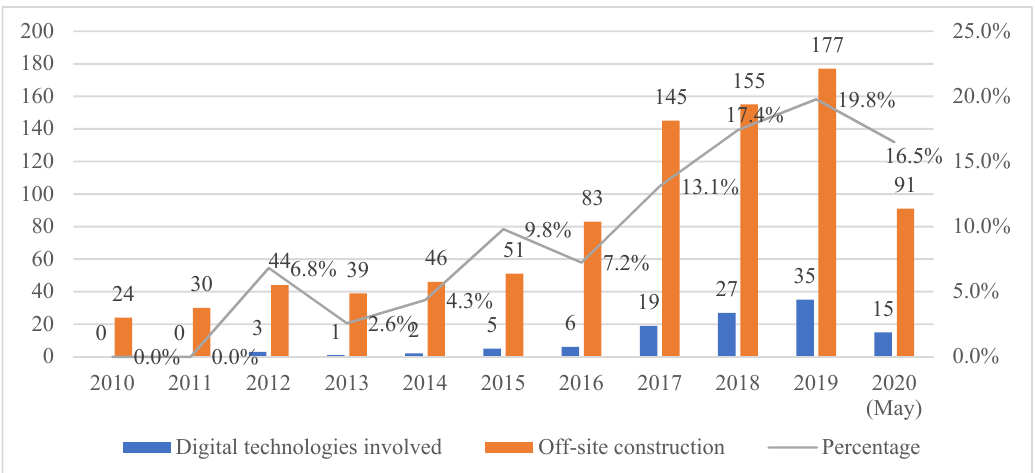
Figure 4. Number of yearly publications of digital technologies involved and total papers in OSC from 2010–2020.